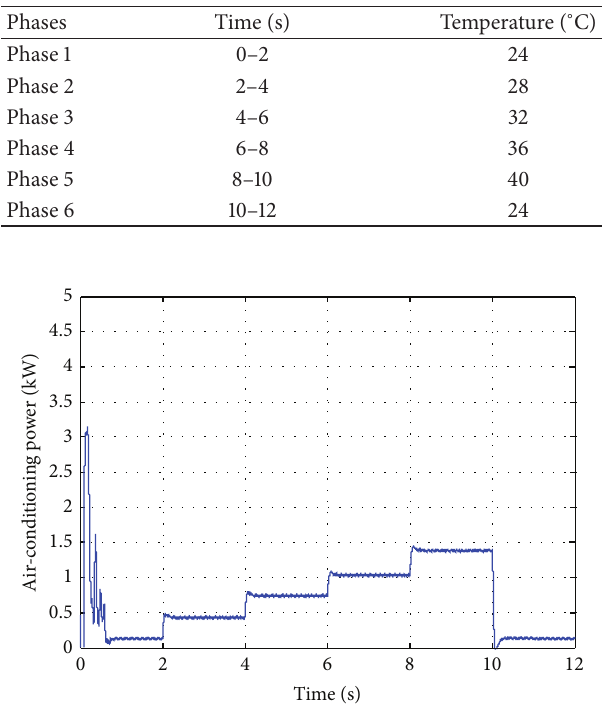
Figure 5: Evolution of Li-ion battery power in different climatic conditions.